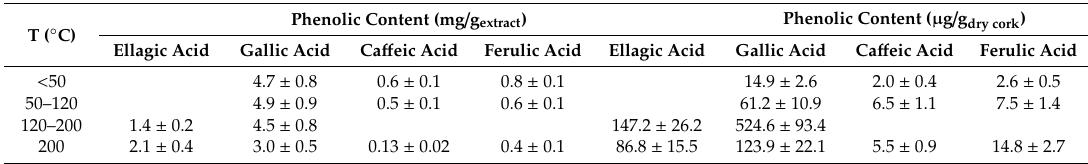
Table 4. Phenolic compounds in the SBW extracts obtained in the assay targeting 200 ◦ C. T ( ◦ C)